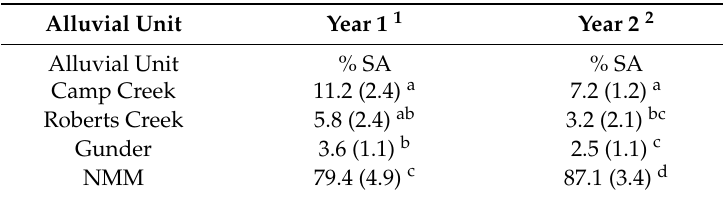
Table 4. Alluvial unit surface area representation within eroding streambank faces for Year 1 (May parentheses indicate standard